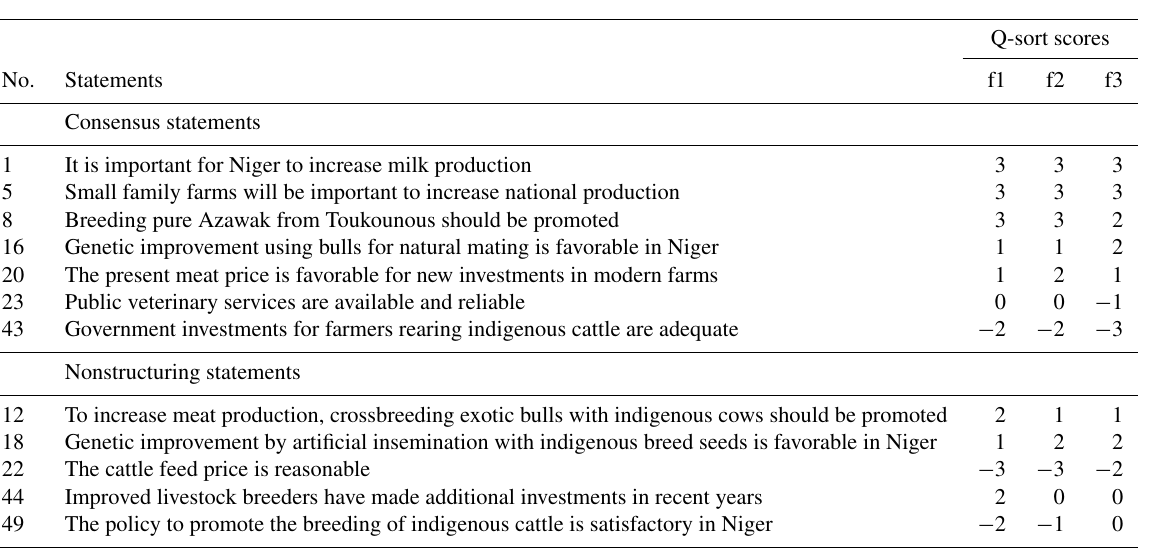
Table 1. Consensus and nonstructuring